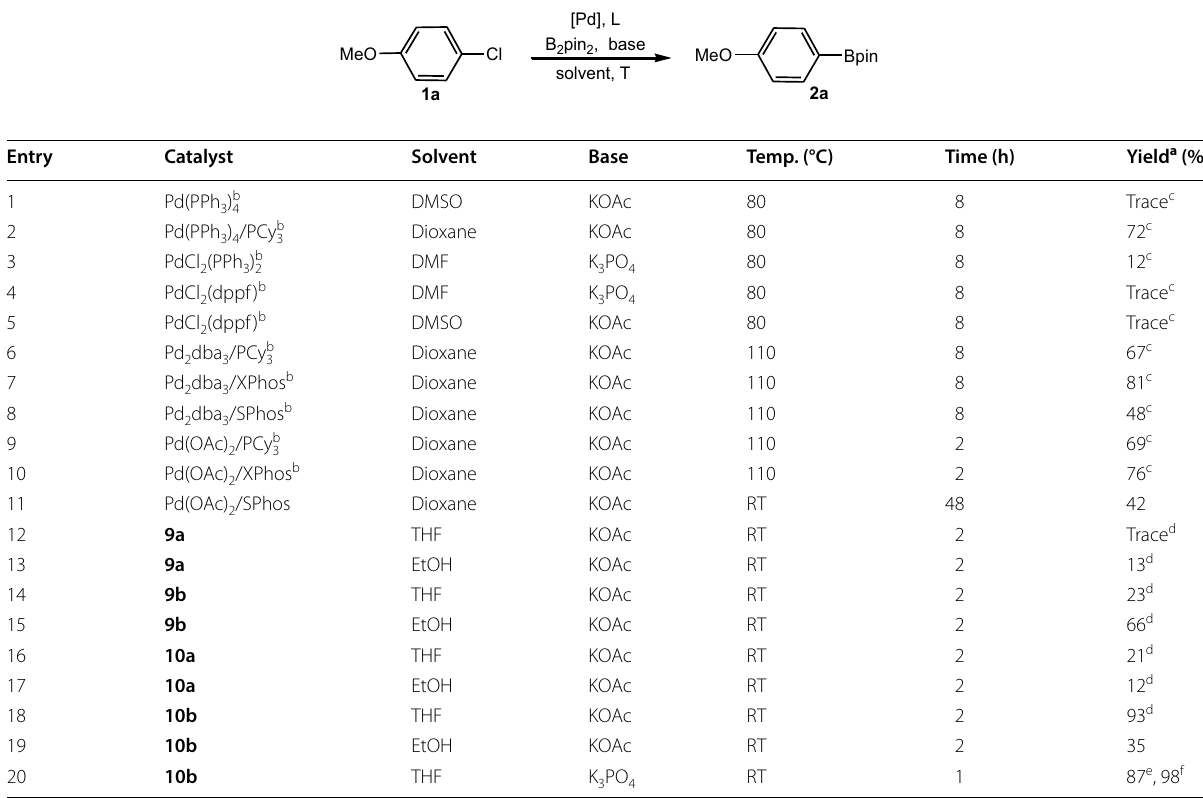
Table 1 Pd-catalyzed borylation of 4-chloroanisole (1a) under various